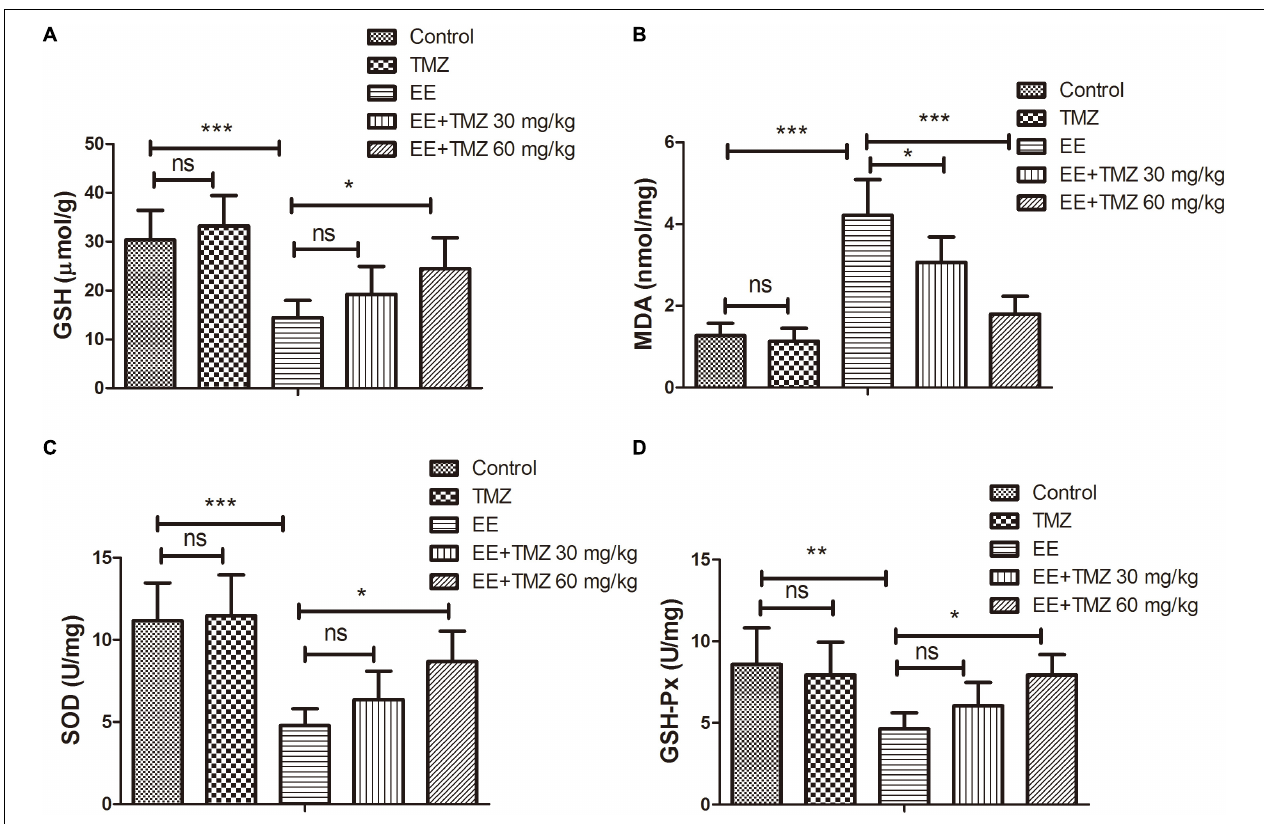
FIGURE 5 | Trimetazidine restrained EE-induced oxidative stress injury in myocardial tissues of rats. The levels of reduced glutathione (GSH) (A) , malondialdehyde (MDA) (B) , and activities of superoxide dismutase (SOD) (C) and glutathione peroxidase (GSH-Px) (D) in myocardial tissues of rats were assessed. Each value is shown as mean ± SD ( n = 6). ∗ P < 0.05, ∗∗ P < 0.01, ∗∗∗ P < 0.001, versus the indicated